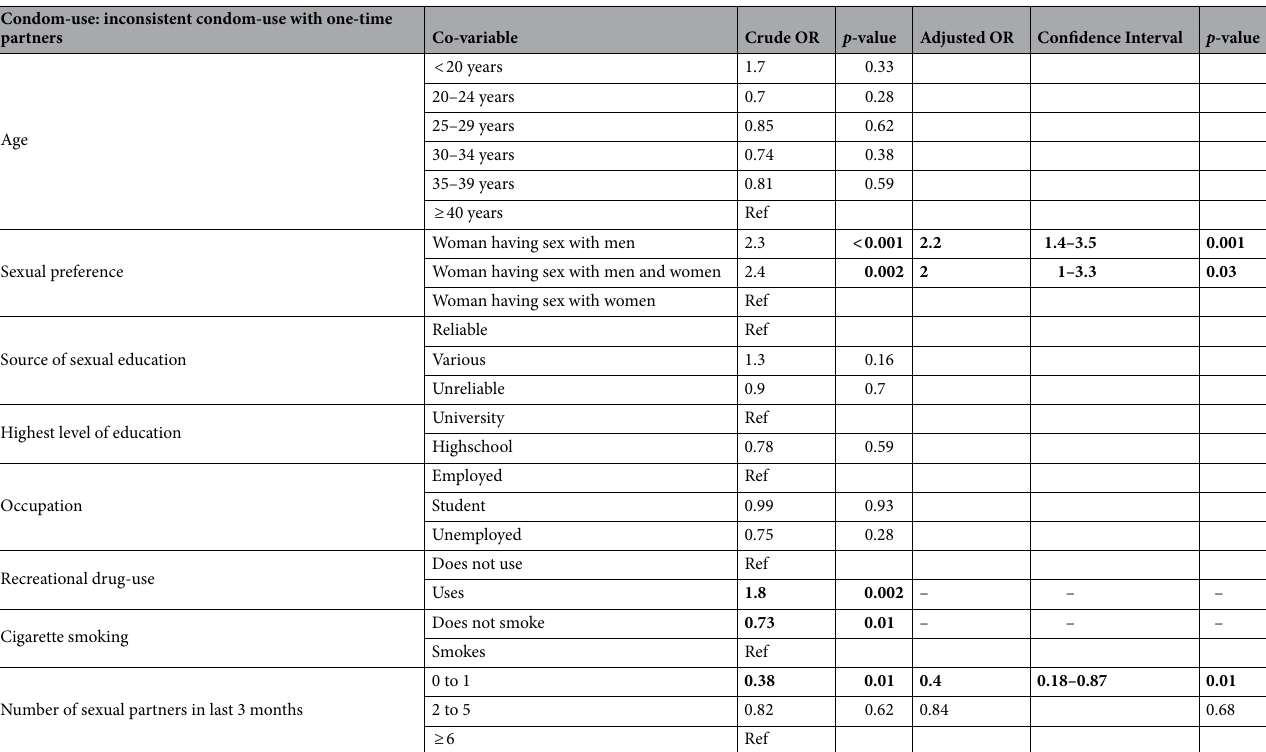
Table 3. Multinomial regression model for condom-use with one-time partner(s) in the past three months with crude and adjusted odds ratios (ORs). Significant results are in